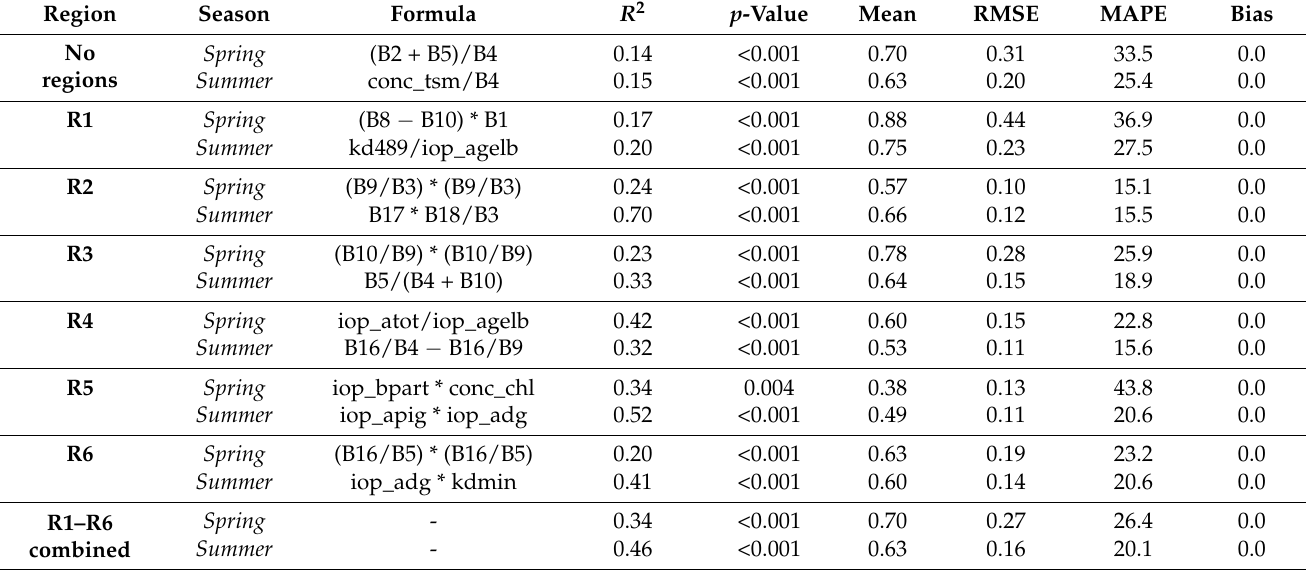
Table 10. The best formulas (B in formulas indicates the C2RCC reflectance band, and the number indicates the band number), the determination coefficient ( R 2 ), p -value, mean and the root mean square error (RMSE) (both in µ molP L − 1 ), the mean absolute percentage error (MAPE), and bias ( µ molP L − 1 ) for each region in spring (April to June) and summer (July to September) for the derived total phosphorus (TP).